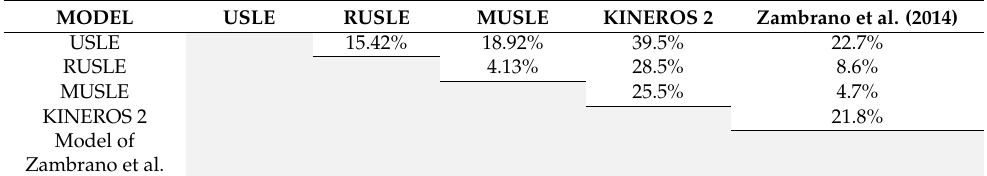
Table 6. Differences between calculated erosion amounts for each method (including Event 7) [3].